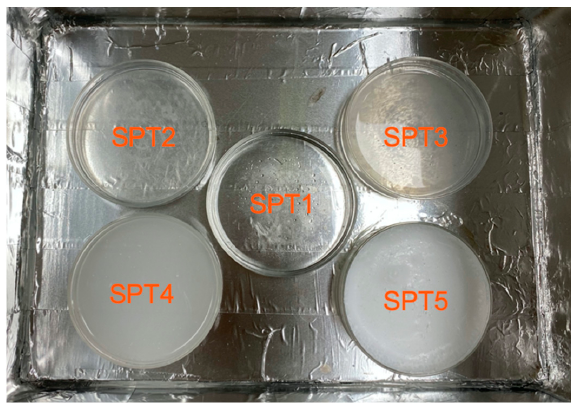
Figure 5. Sample prepared (SPT1 to SPT5) for the optimisation of TiO 2 dose under UVC. The conditions used for the optimisation of TiO 2 dose are summarised in Table 2. In this second experiment, UVC was used for 48 h. The total reaction time was selected based on a mass loss > 90%. The most effective concentration of TiO 2 was evaluated by means of the fibres’ mass loss. Table 2. Summary of the set-up for SP1-SP5 investigating the optimal concentration of TiO 2 under UVC. Each condition was studied in triplicate.